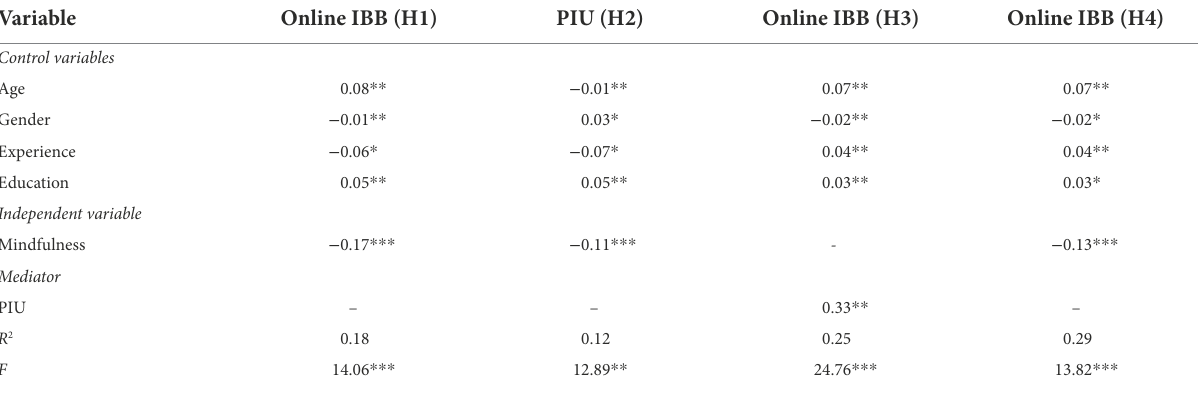
TABLE 4 Results of multiple regression